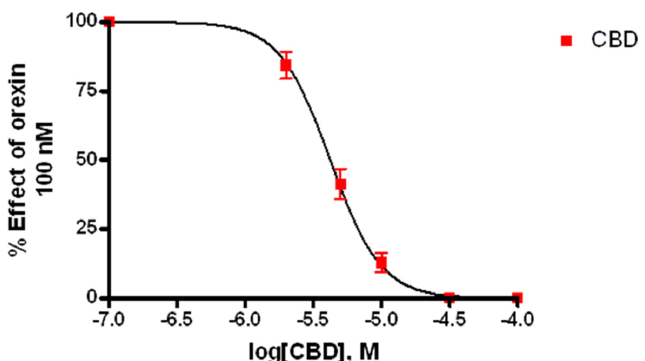
Figure 1. Competition for [ 125 I] orexin-A binding to OX1R-CHO cells (filled circle) and OX2R-CHO cells (filled square) by CBD. Data are the mean of three independent experiments; vertical lines show standard deviation.